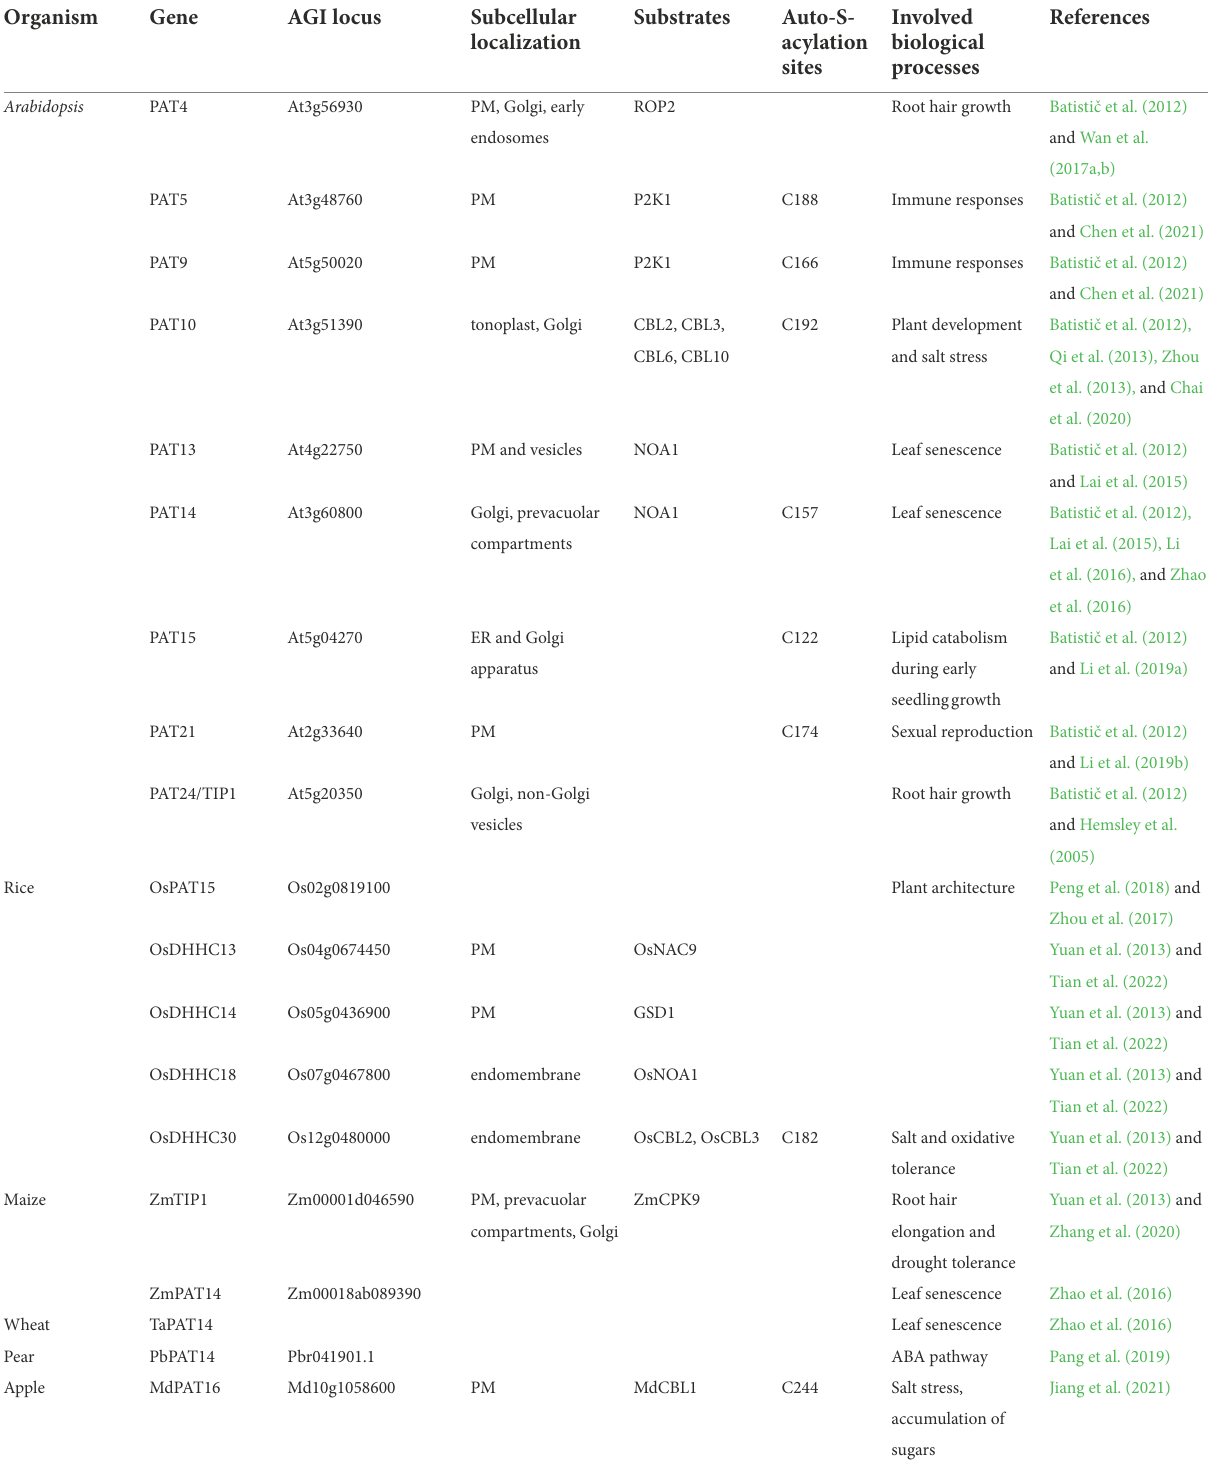
TABLE 2 Functionally characterized PATs in